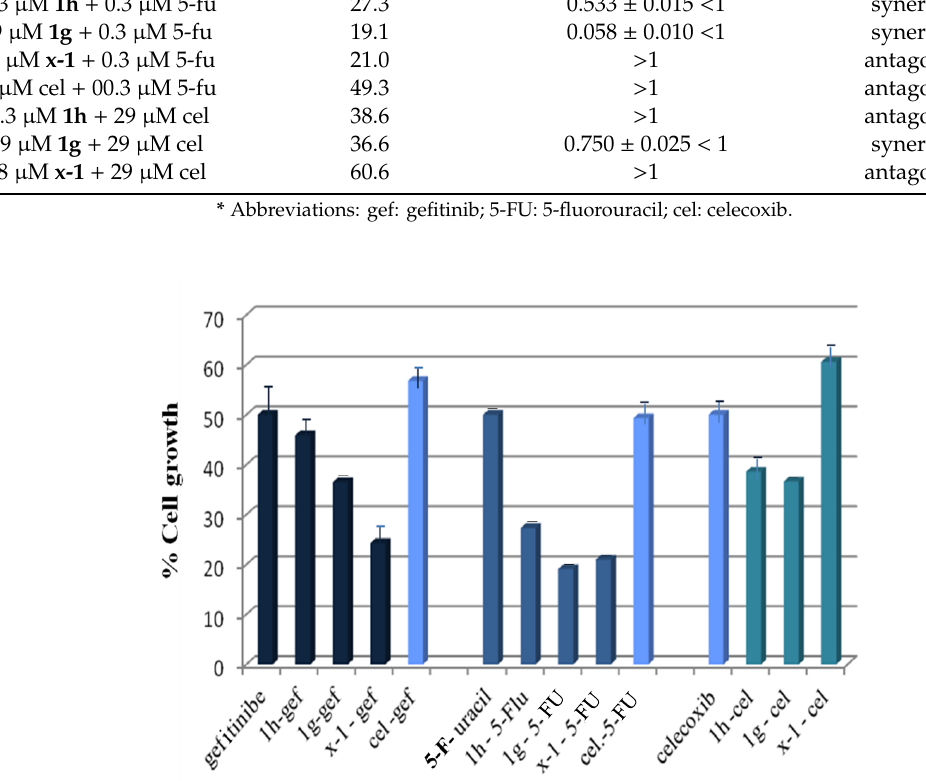
Figure 5. % MCF-7 cell growth rates after cell exposure to the combinations of each COX-2